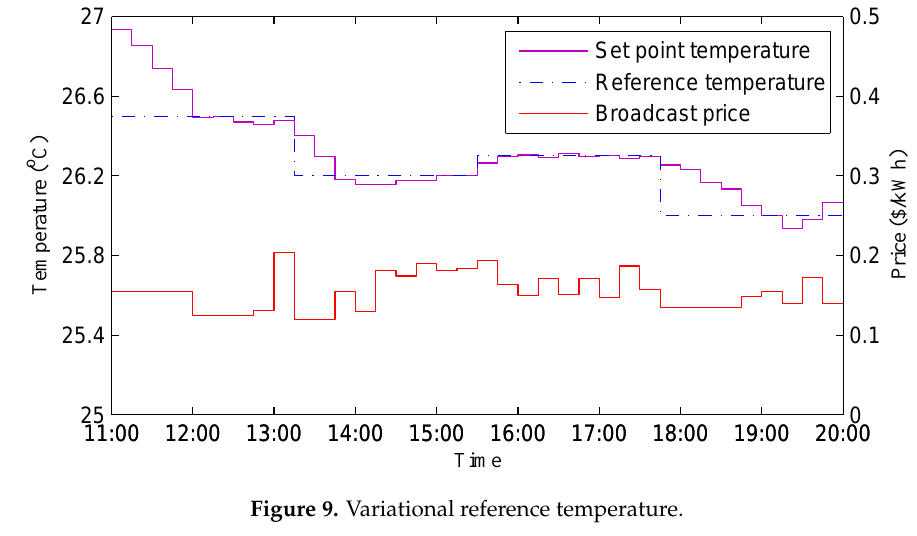
Figure 9. Variational reference temperature.